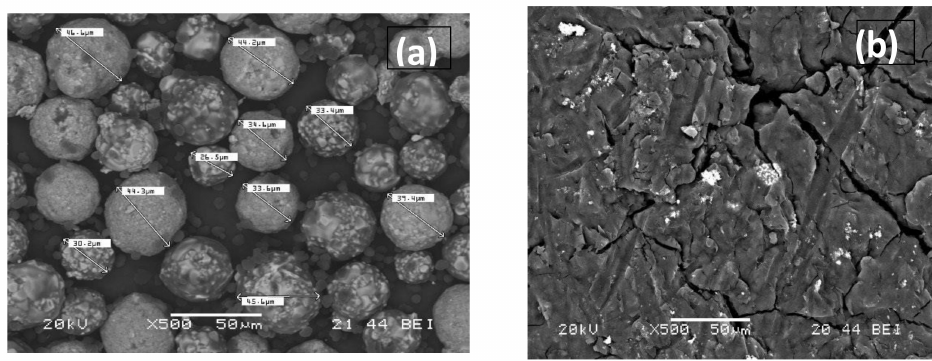
Figure 3. SEM analysis of metallic ( a ) and polymeric ( b ) after Gas chromatography.